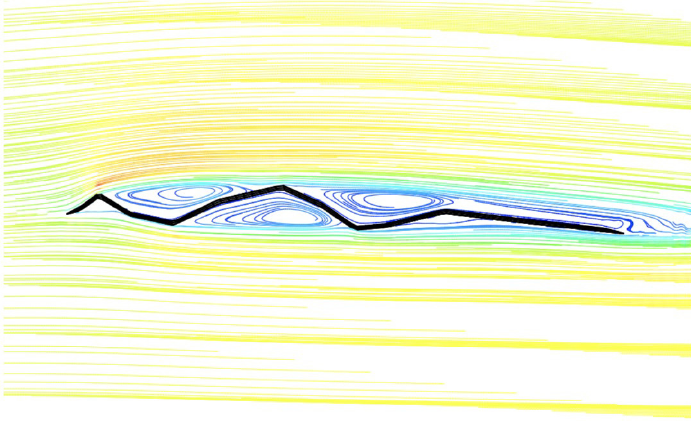
Figure 9. Mean streamlines around a corrugated airfoil at angle of attack of 2 ◦ and Re = 4000.